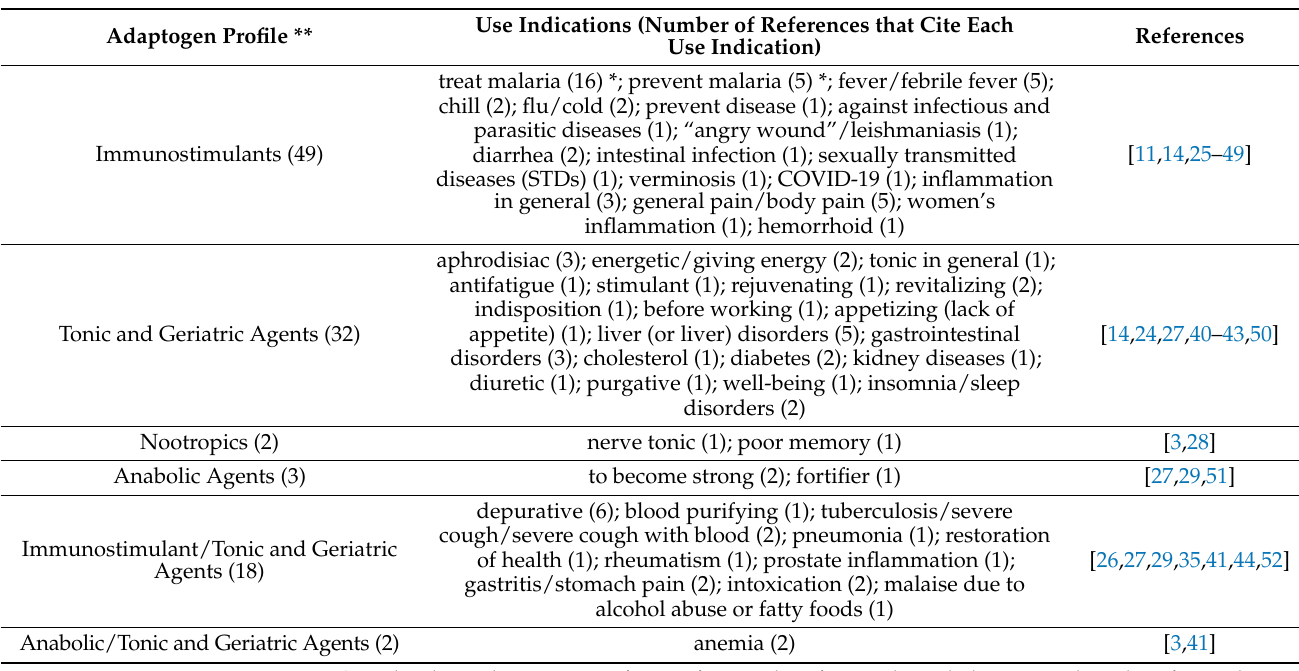
Table 1. Use indications of Ampelozizyphus amazonicus correlated with adaptogen properties in the